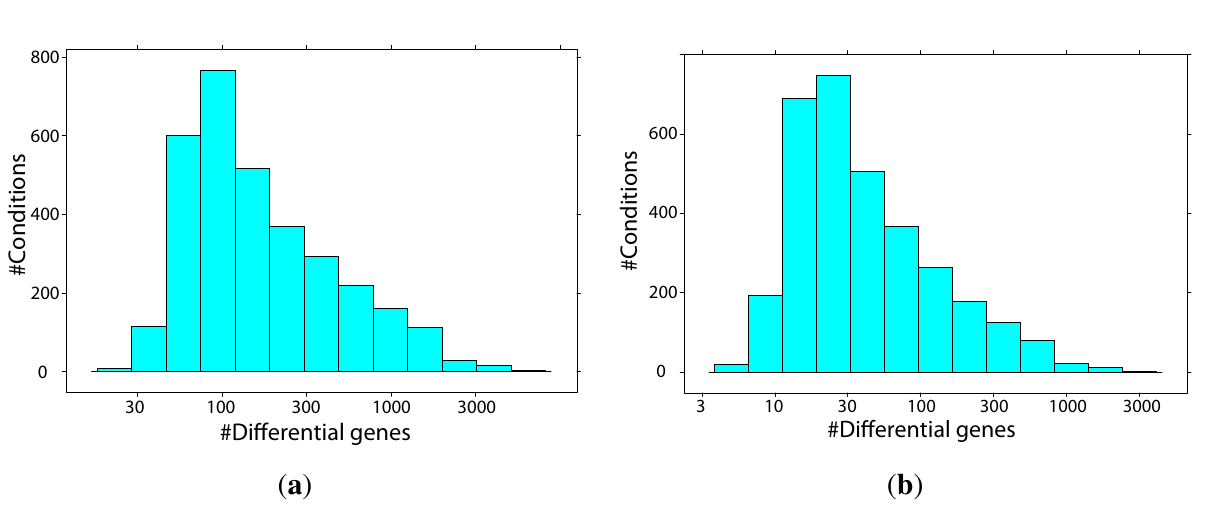
Figure 1. Gene fingerprint sizes for different intensity ratio thresholds. ( a ) Low threshold, 1.5-fold deregulation; ( b ) high threshold, two-fold